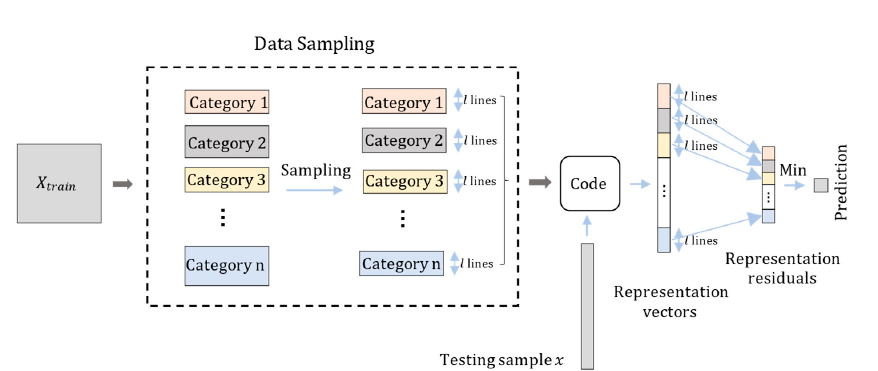
Figure 2. The flow chat of